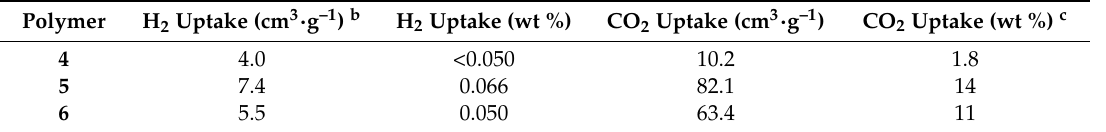
Table 6. Gas uptake values for the polymer networks 4 – 6 a .